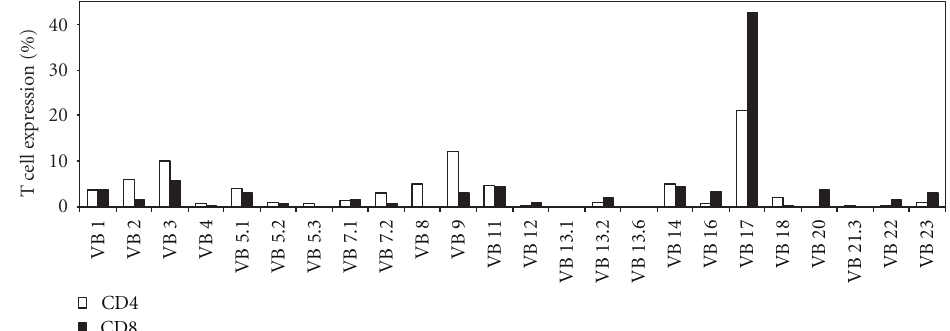
Figure 4: T-cell receptor (TCR) V β repertoire. FACS analysis of the relative expression levels of 24 di ff erent TCR V β families in patient 1 CD3 + CD4 + cells (white bars) and CD3 + CD8 + cells (black bars).